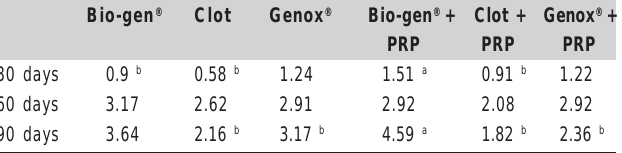
groups at different evaluation times